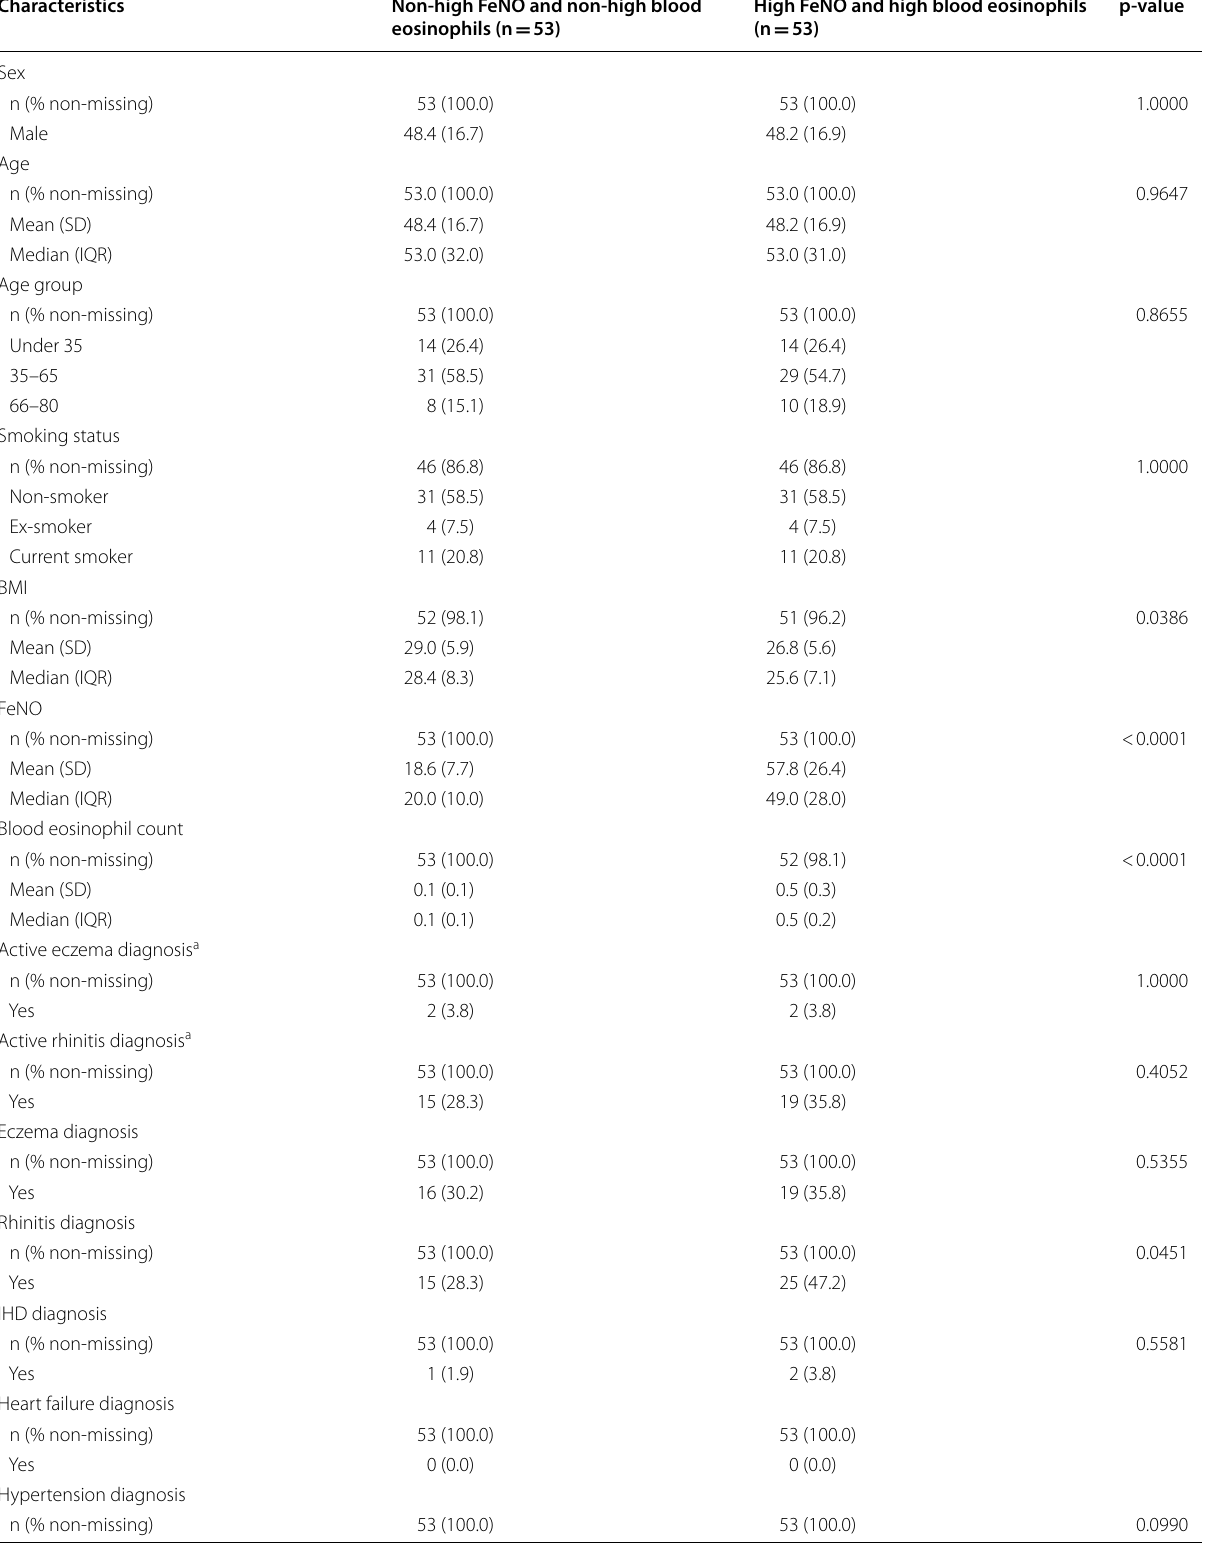
Table 5 Categorisation 2: non-high FeNO and non-high blood eosinophils vs. high FeNO and high blood eosinophils